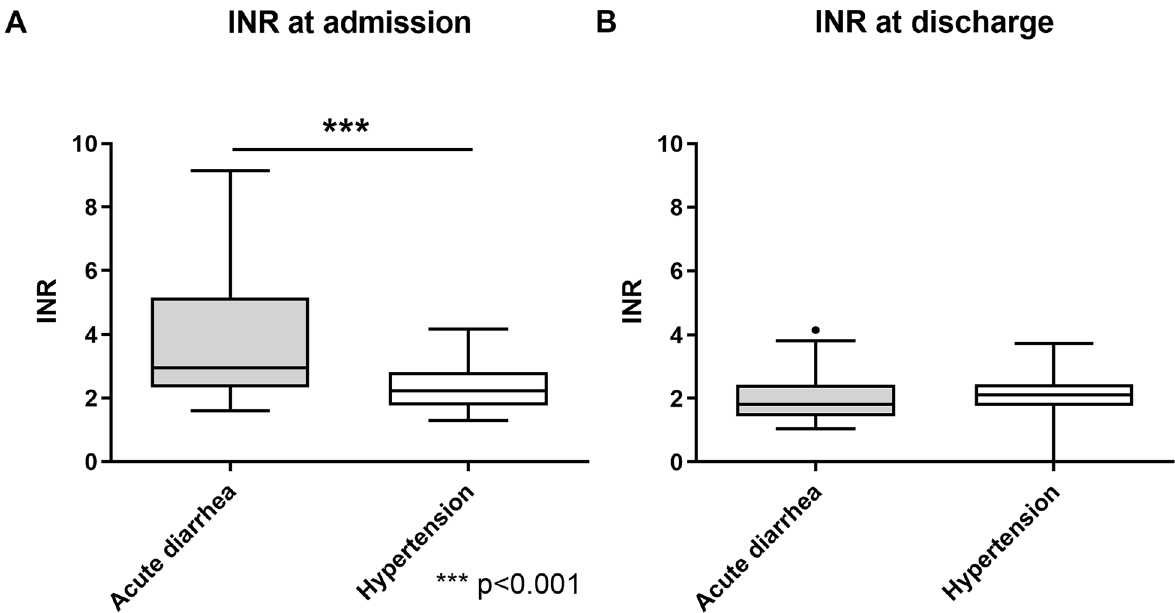
Figure 3. Individual international normalized ratio (INR) values ( A ) at admission and ( B ) at discharge in subjects with acute diarrhea and hypertension (control group) receiving vitamin K antagonists. *** p < 0.001 (unpaired two-tailed t